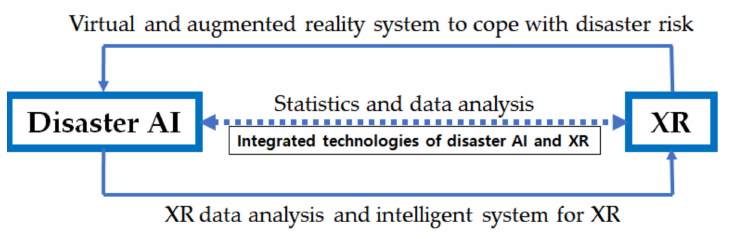
Figure 11. Technological structure diagram of integrated technologies of disaster AI and